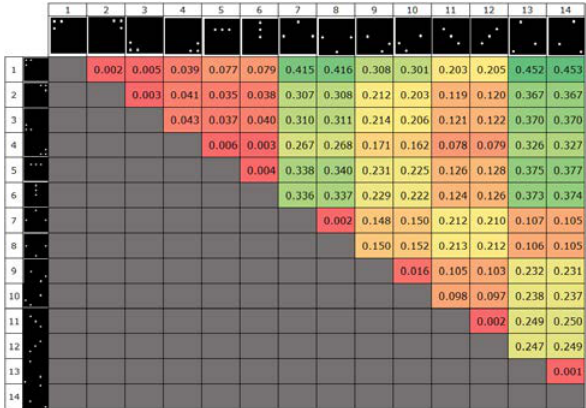
Table 1: The result of the matching experiment.